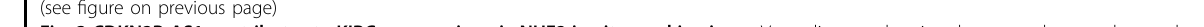
Fig. 3 CDKN2B-AS1 contributes to KIRC progression via NUF2 in vitro and in vivo. a Venn diagram showing the genes that may be regulated by CDKN2B-AS1 (54 genes), co-expressed with CDKN2B-AS1 (270 genes), or both (4 genes). b , c qRT-PCR analysis of NUF2, MICALL2, MICAL1, and AGBL2 expression in 769-P and ACHN cells transfected with the si-CDKN2B-AS1 mix for 48 h, β -actin was used as the internal control ( b ); western blot analysis of NUF2 protein expression with GAPDH as the internal control and quantitation of protein levels performed using densitometry ( c ). d – g 769-P and ACHN cells were transfected with si-CDKN2B-AS1 mix plus pcDNA3.1-NUF2 plasmid for 48 h; CCK-8 ( d ), colony formation ( e ), and EdU ( f ) assays were performed to assess cell viability and proliferation; transwell assays ( g ) were used to evaluate cell migration and invasion; ImageJ software was used for cell counting. Scale bar: 50 μ m. h – l qRT-PCR analysis of CDKN2B-AS1, NUF2, vimentin, MMP9, MMP2, AXIN-1, N-cadherin, and E-cadherin expression in tumor tissues of BALB/c nude mice subcutaneously injected in the fl ank with ACHN cells pre-infected with the lentiviral vector ( n = 5 per group); β -actin was used as the internal control ( h , l ); growth curves of tumors in the nude mice ( i ); representative images ( j ), and weight of the xenografts derived from the nude mice ( k ). Error bars represent the SEM, ** p < 0.01 vs. si-NC; * p < 0.05 vs. si-NC or si-NC + pcDNA3.1- vector or pGLV3-shNC + pLenti-vector; # p < 0.05 vs. si-CDKN2B-AS1 mix + pcDNA3.1-vector or pGLV3-shCDKN2BAS1 + pLenti-vector. Data are representative from at least three independent experiments, p value calculated by independent sample t test ( b , c ), one-way ANOVA and Student – Newman – Keuls test ( d – i, k , l